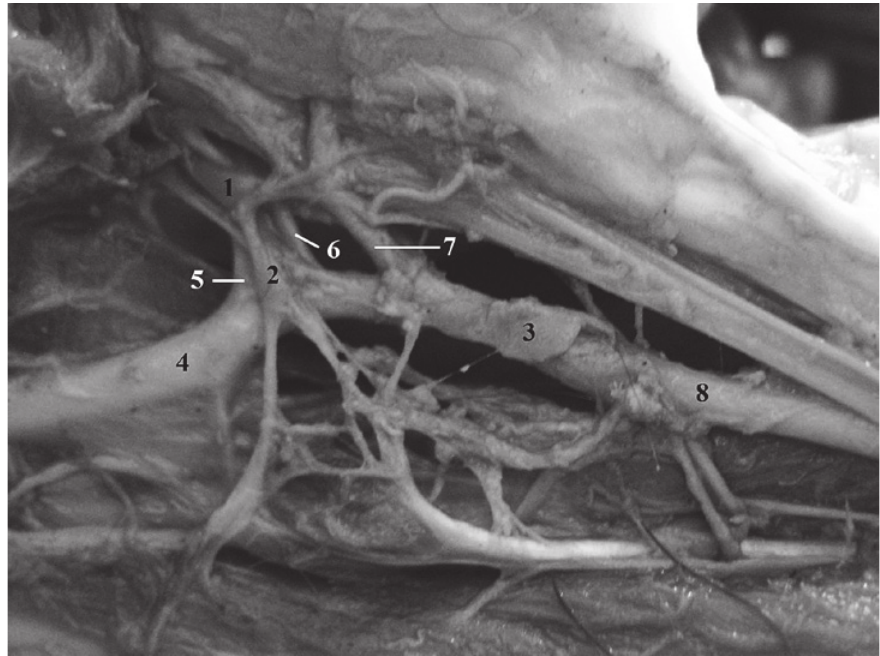
Fig 3 - Photomacrography of Saguinus niger right sympathetic trunk in abdomen in ventral view demonstrating the cranial mesenteric ganglion (1) , celiac ganglion (2) , caudal mesenteric ganglion (3) , abdominal aorta (4, 8) ,